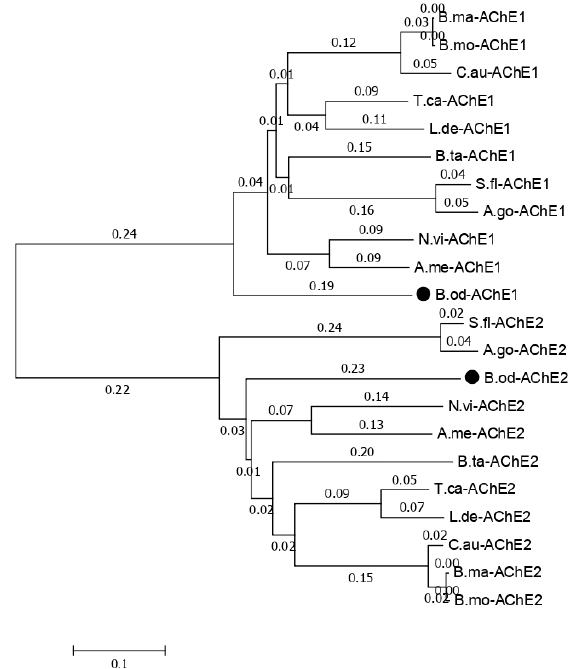
Figure 7. Phylogenetic relationships of the two Bradysia odoriphaga acetylcholinesterase genes (AChEs) with those from other insects. A phylogenetic tree was generated using a Clustal W alignment and neighbor-joining method with 1000 bootstrap replicates in MEGA 7.0 (Molecular Evolutionary